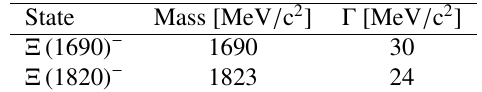
Table 1. Implemented mass and width of the resonances.